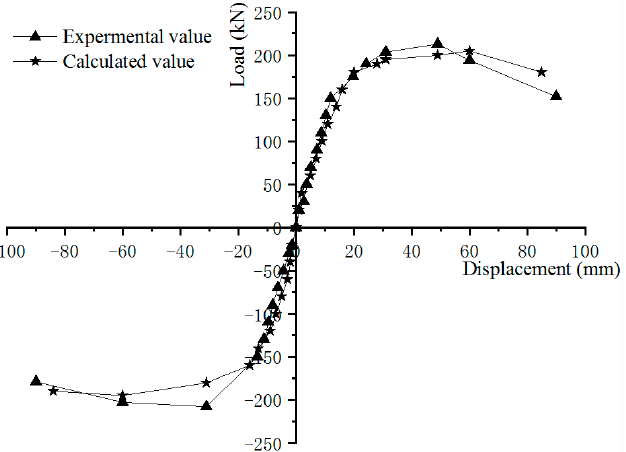
Figure 18. The comparison between the KJ-1 curve and the curve of the finite element analysis.